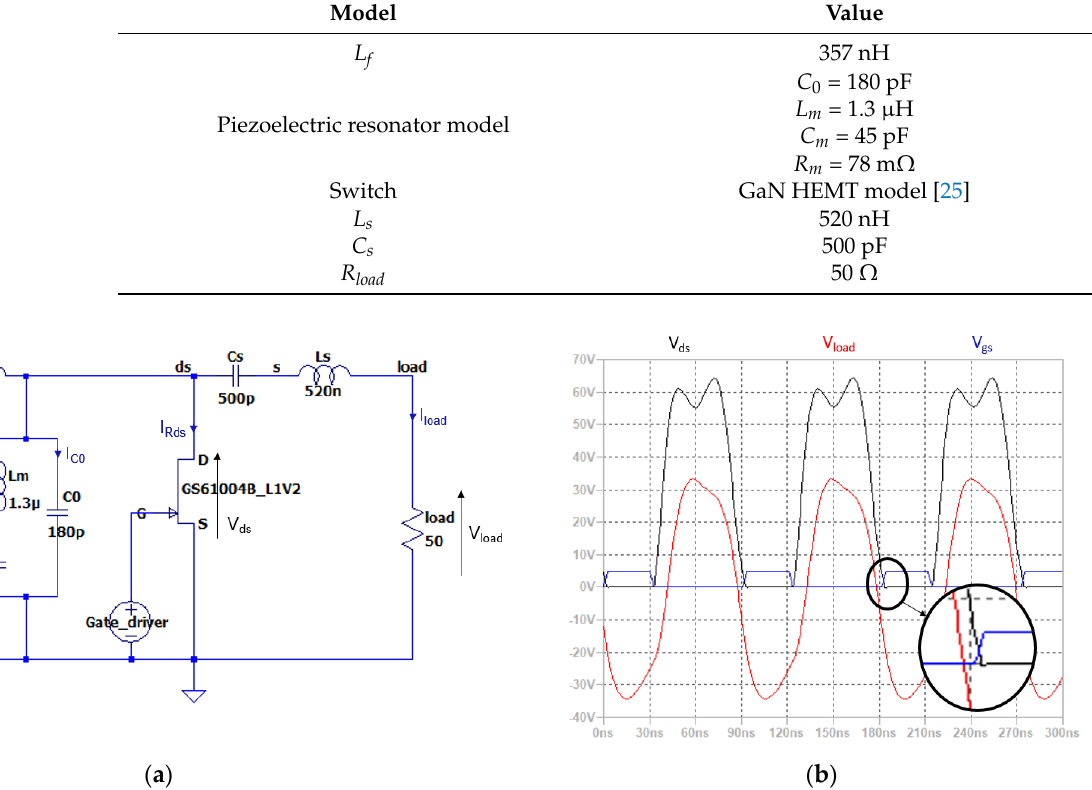
Table 3. Values of the components of the L − piezo converter.